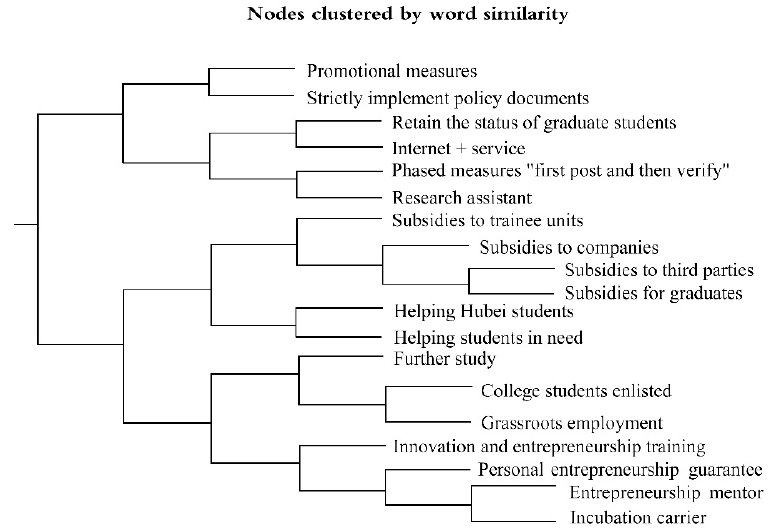
Figure 3. Cluster analysis result diagram.